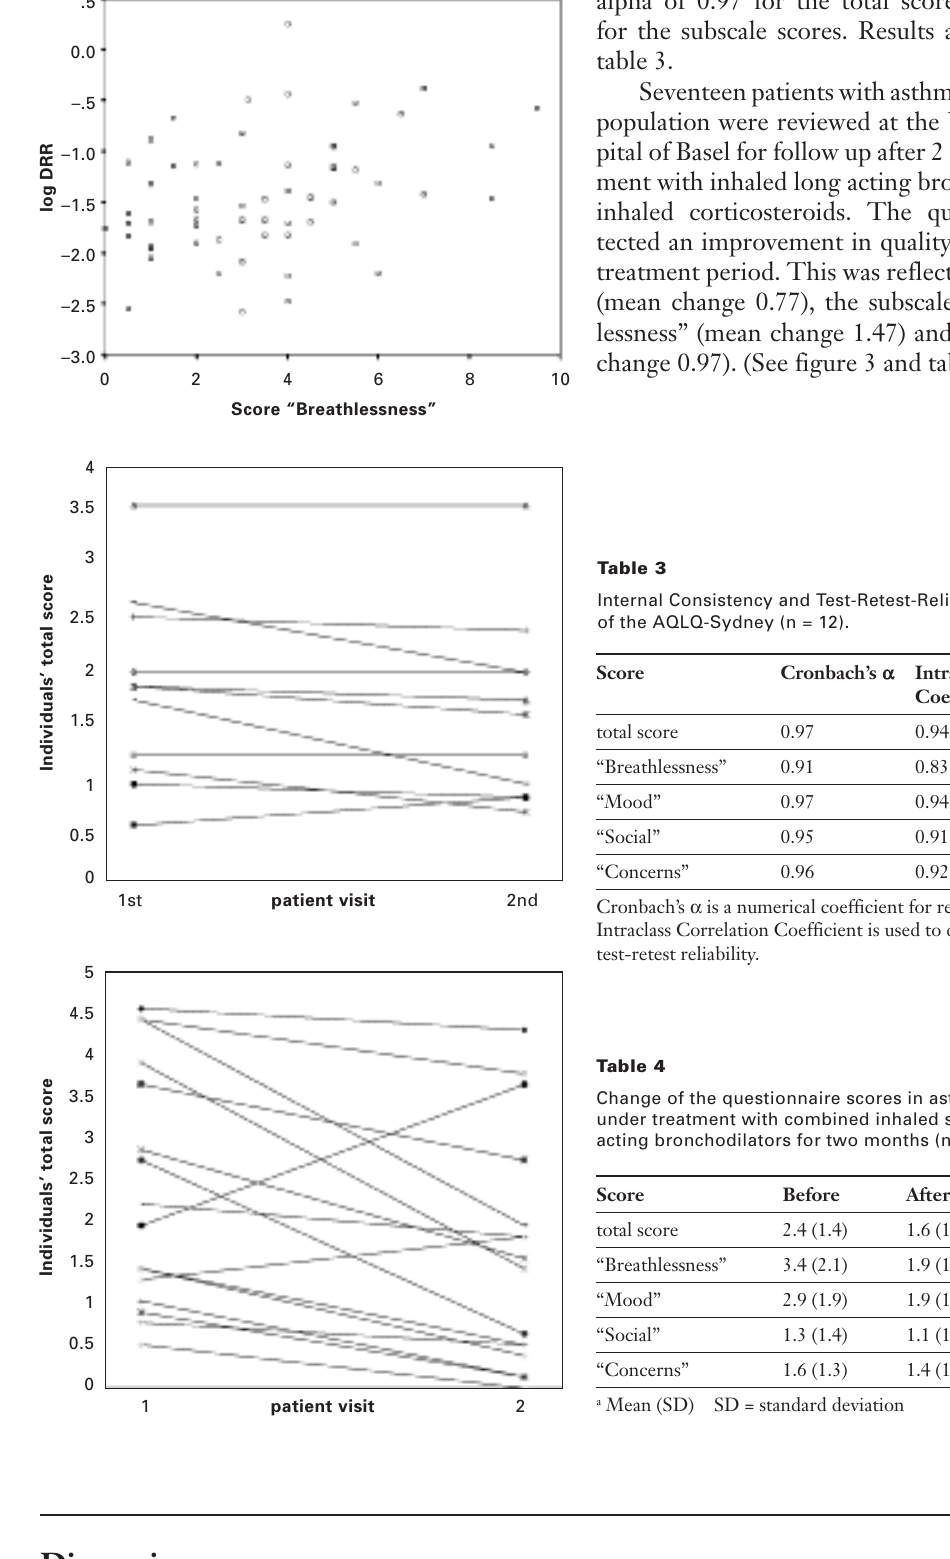
Correlation between the clinical variable dose response ratio methacholine (log- DRR) and the AQLQ- Sydney score “Breathlessness” (n = 57, rho = 0.32).